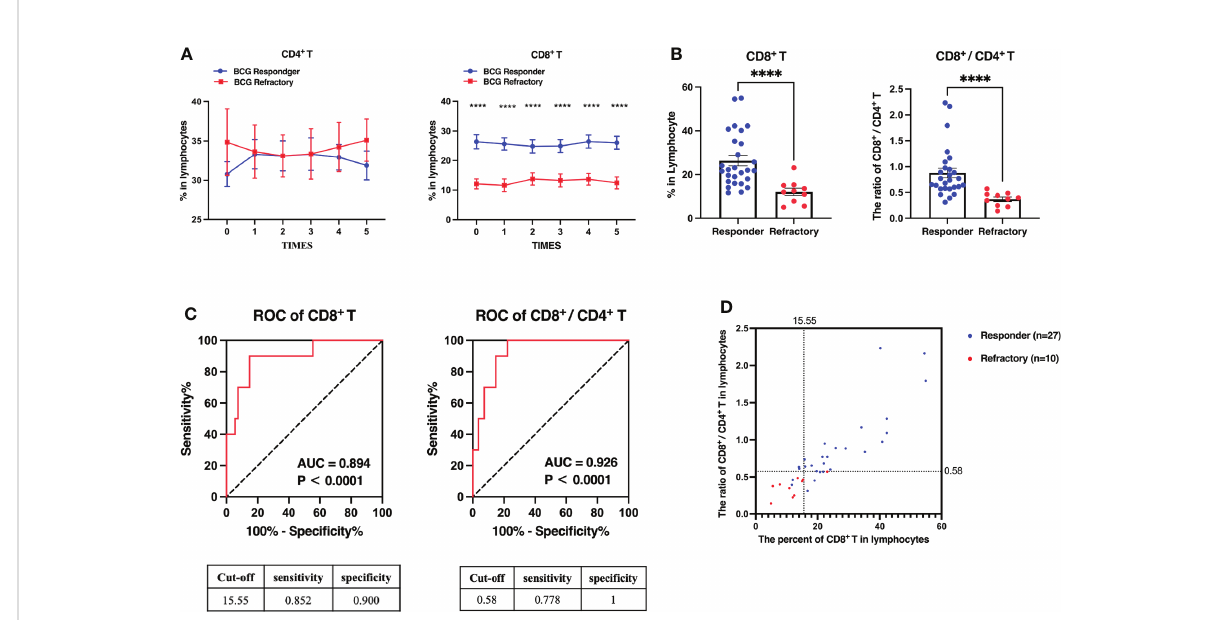
FIGURE 4 The percentages of CD8 + T cells and the ratio of CD8 + /CD4 + at the baseline are more predicable for a better prognosis of BCG instillation. Patients were strati fi ed into “ BCG responder ” (n = 27) and “ BCG refractory ” (n = 10) based on the clinical evaluation within 6 months, as described in the “ Methods and Materials ” section. (A) The percentages of CD4 + or CD8 + T cells among the total lymphocytes in the induction phase. (B) The percentages of CD8 + T cells and the ratios of CD8 + /CD4 + before the BCG instillation. (C) ROC analysis of the percentages of CD8 + T cells and the ratio of CD8 + /CD4 + . (D) A scatter plot illustrated how recurrence-free patients and those with recurrence may be discriminated based on the percentages of CD8 + T cells and the ratio of CD8 + /CD4 + cells before BCG instillation. Blue circles indicate BCG responder, red circles indicate BCG refractory. ****P <